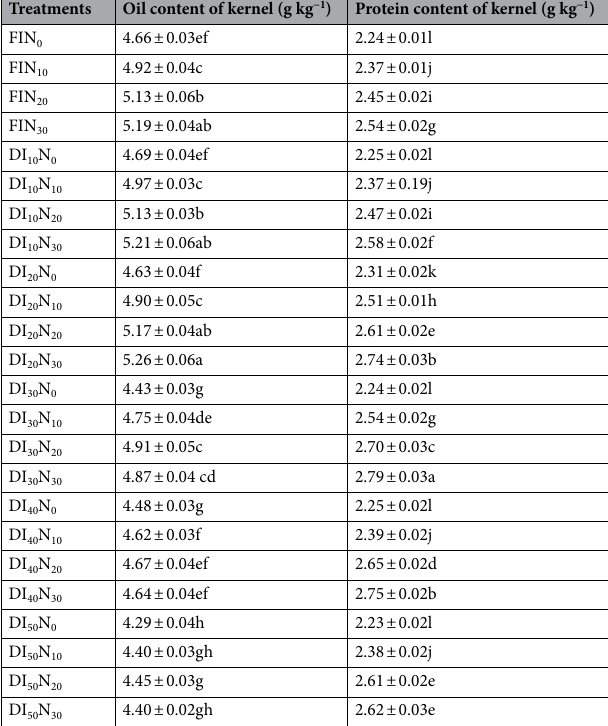
Table 2. Content of oil and protein in kernel of peanut under different irrigation and nitrogen application rate treatments [Values are mean ± standard error, n = 9 (3 × 3; 3 growing seasons and 3 replications per treatment)]. Values within a column for each variable followed by different letter/s are significantly different at P < 0.05 level. The details of treatments are given in Table 1.